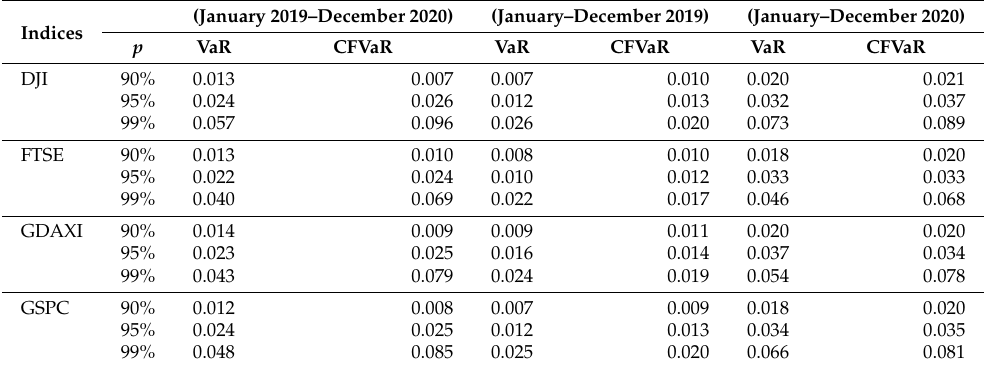
Table 7. Value at Risk (VaR) and Cornish–Fisher expansion (CFVaR) estimations—Stock market